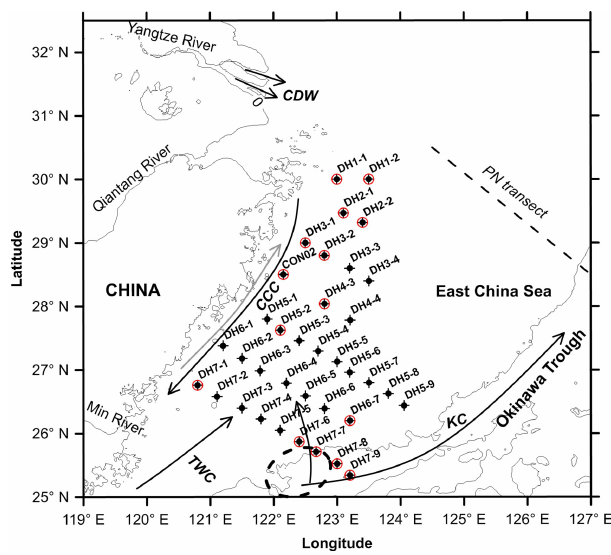
Figure 1. Map showing the locations of suspended particulate mat- ter (SPM) collected around the deep chlorophyll maximum (DCM) layer from the East China Sea during summer (22 June–21 July) 2013 for the present investigation. Also shown is the modern current pattern in the East China Sea. Red circles mark the SPM samples that were collected from the water depths either below or above but mostly contiguous to the DCM layer. CDW – Changjiang Diluted Water, CCC – China Coast Current, TWC – Taiwan Warm Current and KC – Kuroshio Current. The dashed ellipse represents the cen- ter of Kuroshio upwelling, occurring due to an abrupt change in the bottom topography, in the north-east of Taiwan Island (Wong et al., 2000). Also shown is the PN transect, a cross-shelf transect in the East China Sea in which particulate organic matter dynamics is relatively well